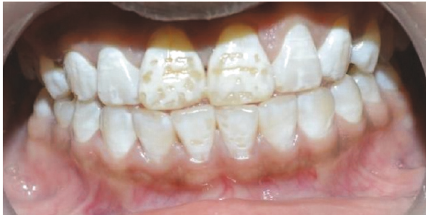
Figure 1: Pretreatment photograph showing severely pitted appear- ance.